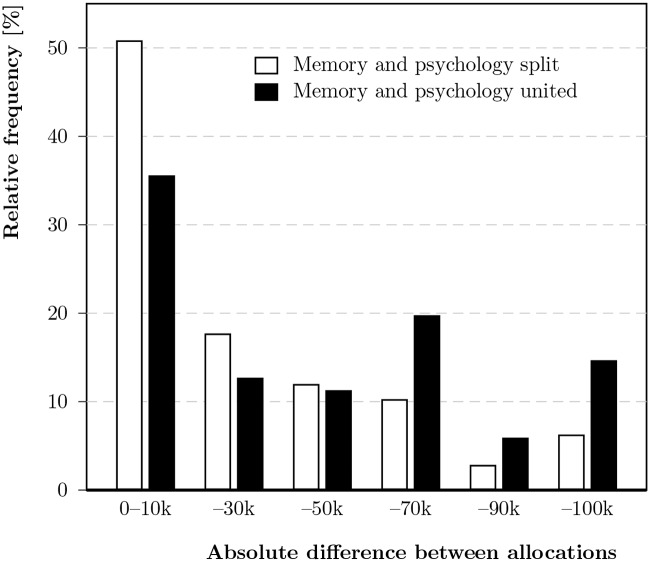
Relative frequency of absolute allocation differences, separately for conditions in which memory and psychology were split vs. united (intervals include the upper limit).